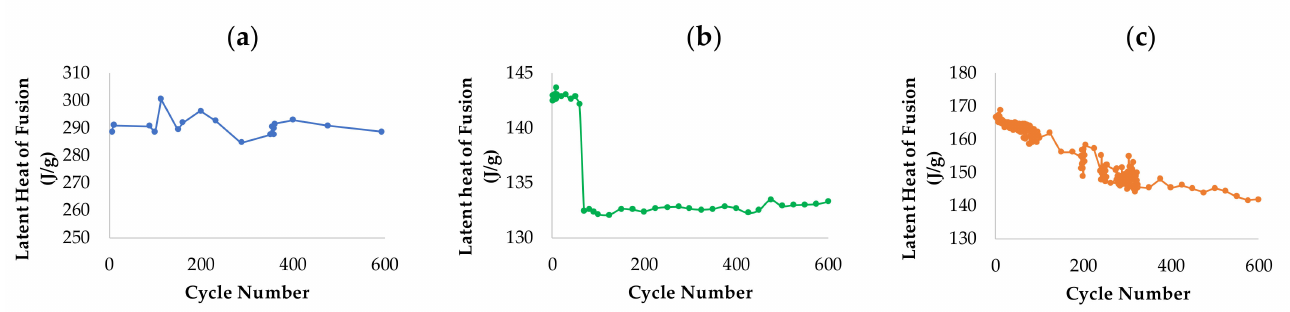
Figure 1. ( a ) Latent heat (Hf) as a function of cycle number up to 600 cycles for sodium formate, ( b ) sodium/potassium formate, and ( c ) sodium/calcium